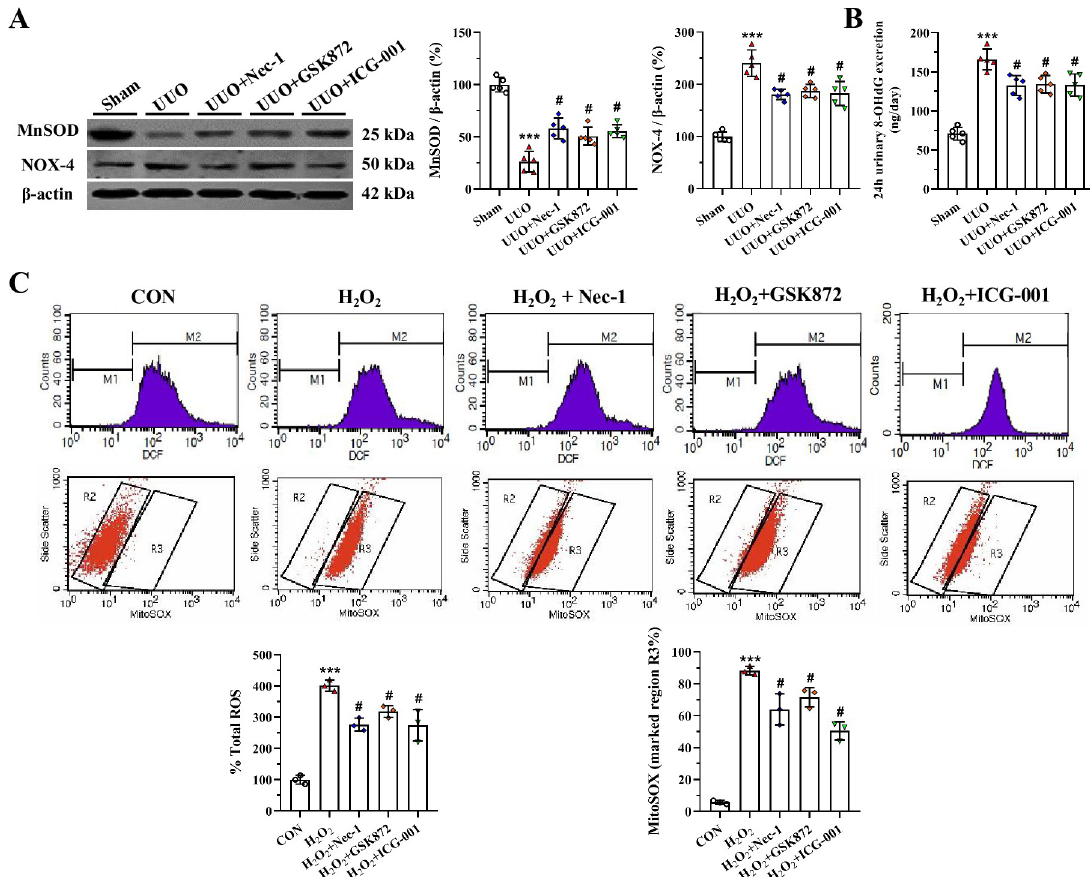
Fig 4. Representative photomicrographs of immunoblotting analysis (A), urine 8-OHdG concentration (B), and intracellular ROS and MitoSOX production in HK-2 cells (C and D). ��� P < 0.01 vs. sham or control; # P < 0.05 vs. UUO or H 2 O 2 .